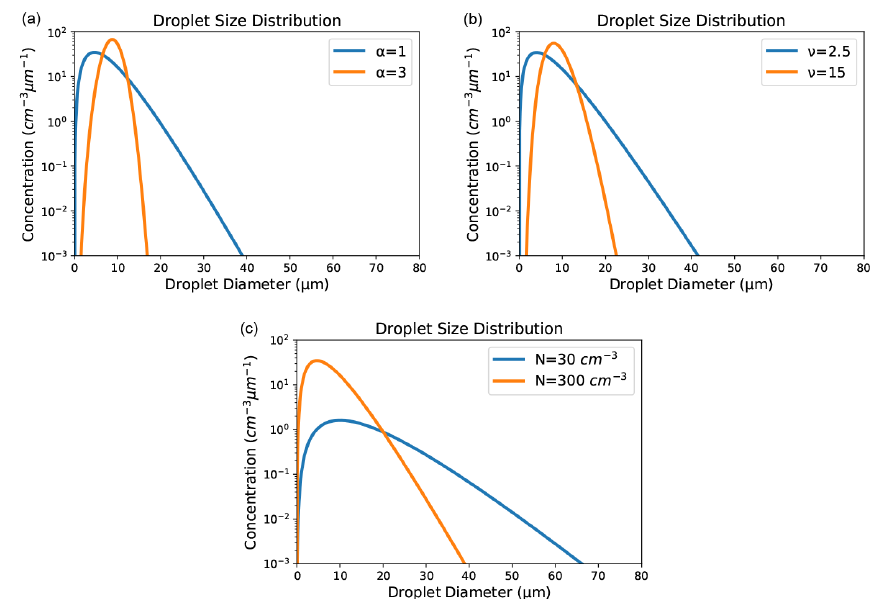
Figure 5. Modified gamma distributions for a liquid water content of 0.12gm − 3 prescribed by the ICE-3 scheme. From (a) : α = 1 and α = 3 (default = 1), ν = 2 . 5 and ν = 15 (default = 3), and N = 30cm − 3 and N = 300cm − 3 (default = 300cm − 3